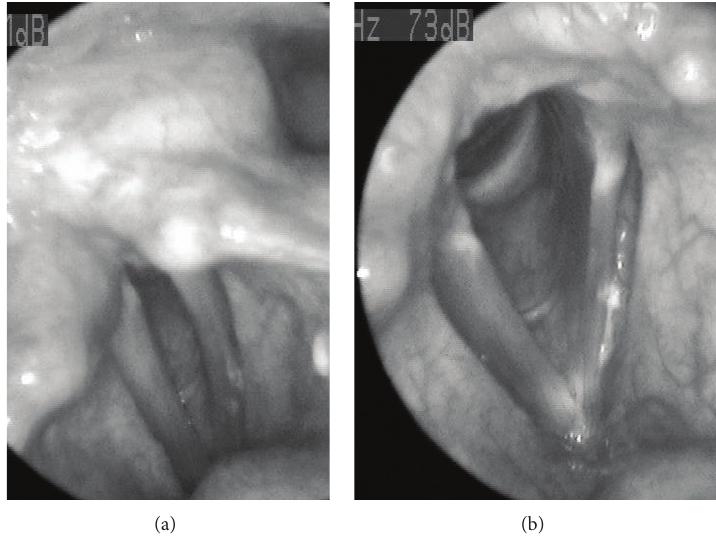
Figure 1: Laryngoscopic images during phonation (a) and inspiration (b).